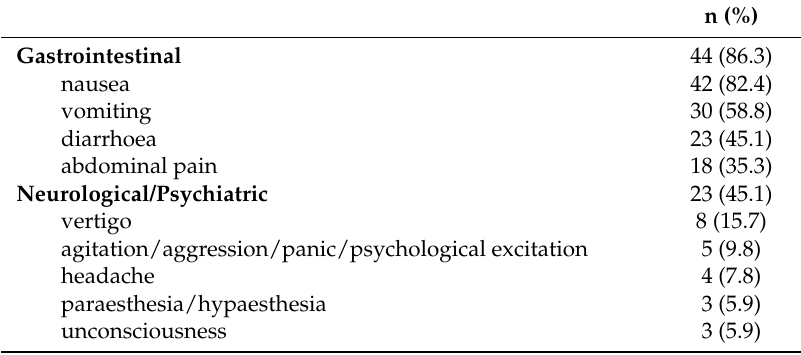
Table 3. Clinical characteristics of mushroom poisoning (N =